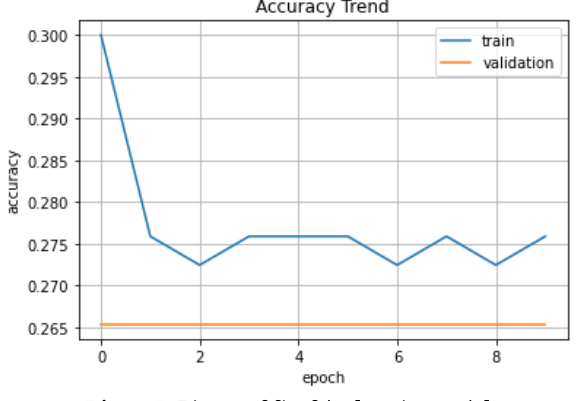
Figure 5. Fitness of fit of the learning